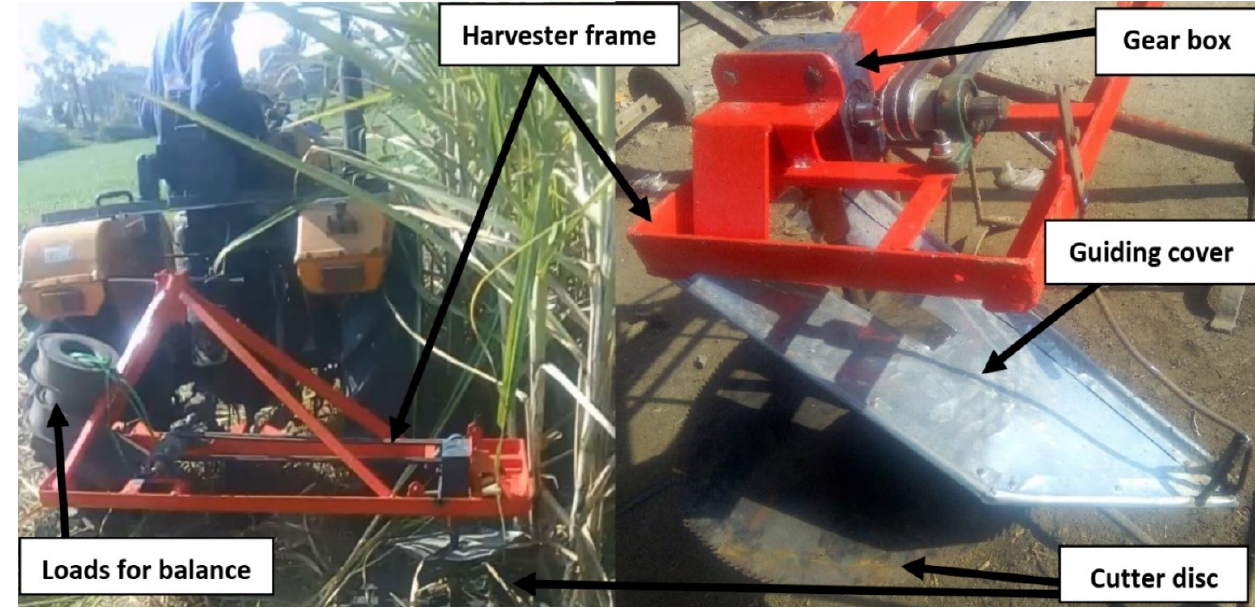
Figure 2. Fabricated sugarcane harvester prototype mounted on a tractor.